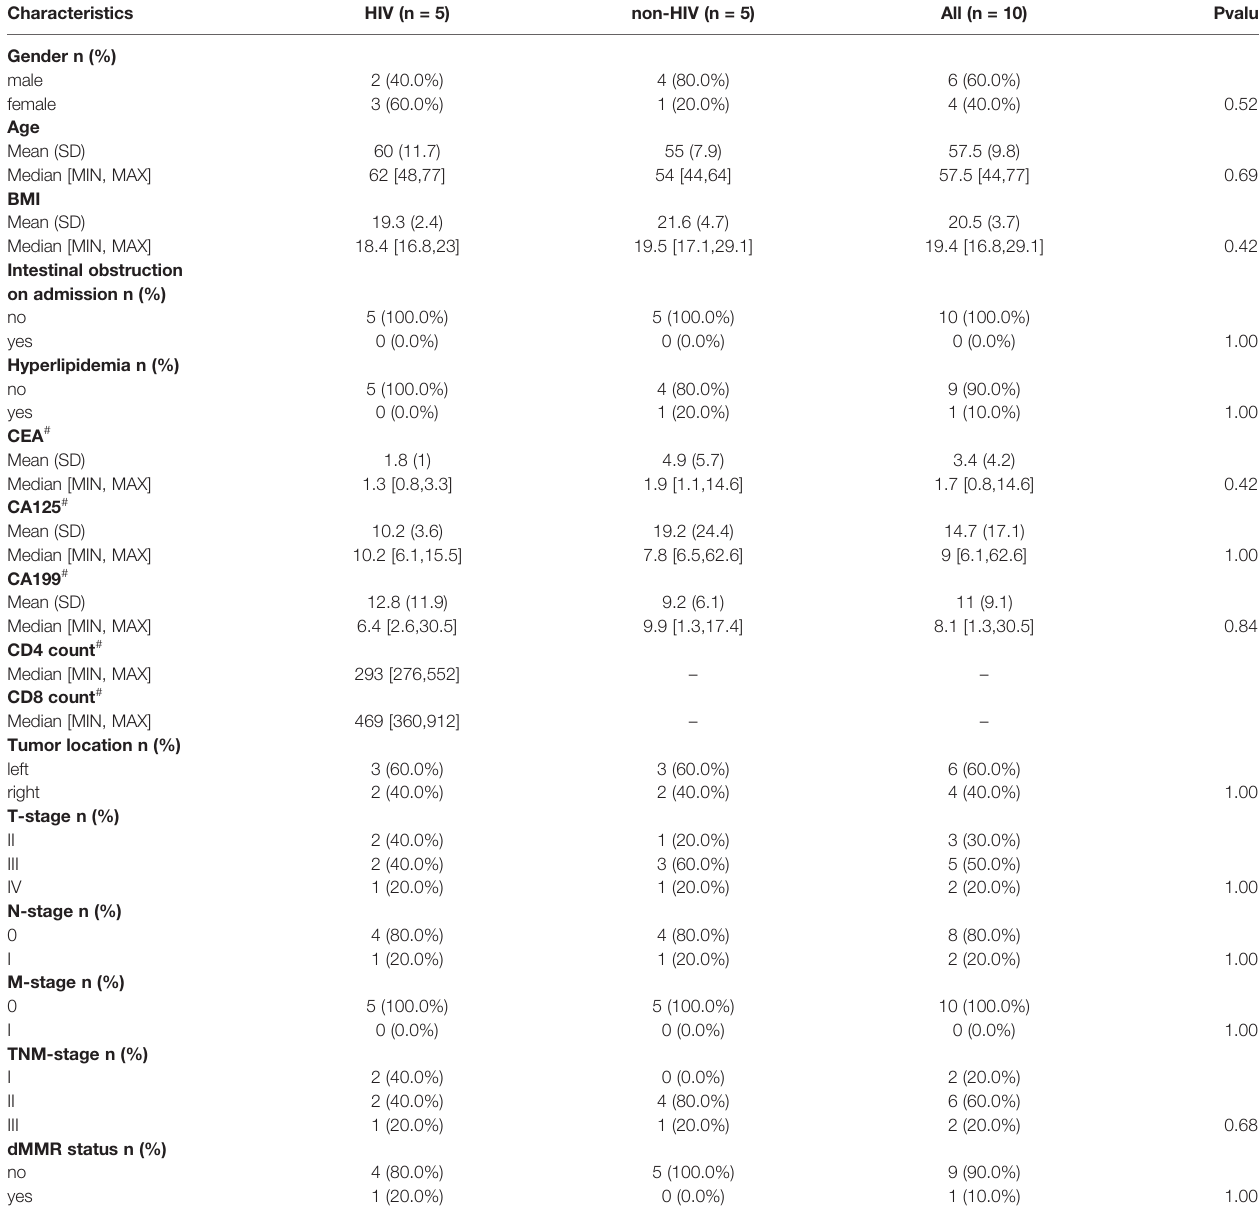
TABLE 1 | Patient Characteristics.